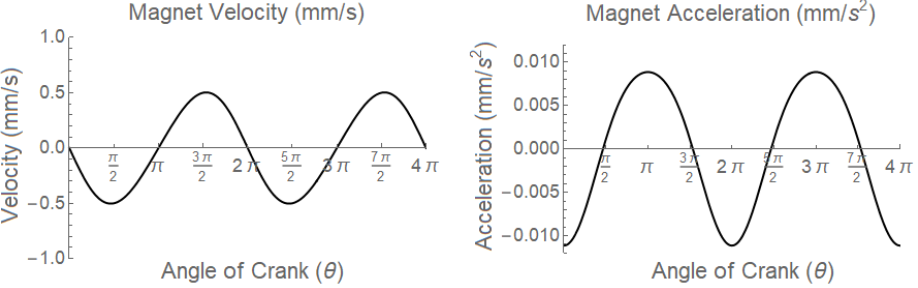
Figure 7 is a sample output of ˙ x from Formula (8) and ¨ x from Formula (10) with the given values for ω , r , and l for this experiment. It is significant to note the critical components of motion for the magnet. At θ values equal to 0 or 2 π and multiples thereof, the magnet is outside the coil, its ˙ x is zero, and the magnet is at its minimum and maximum positions relative to the crank. At θ of π , 3 π , and their multiples, the magnet’s ˙ x is zero and this is where the theoretical and experimental central position of the coil ismounted. Additionally, the maximum acceleration of the magnet portion of the crank-slider harvester occurs when θ is 0, where the mechanism is at its elongated maximum, and the magnet is outside the coil.